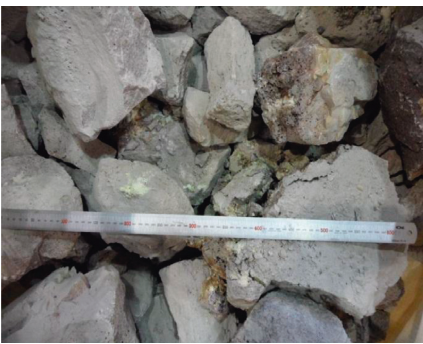
Figure 1: Raw material of STS-refining